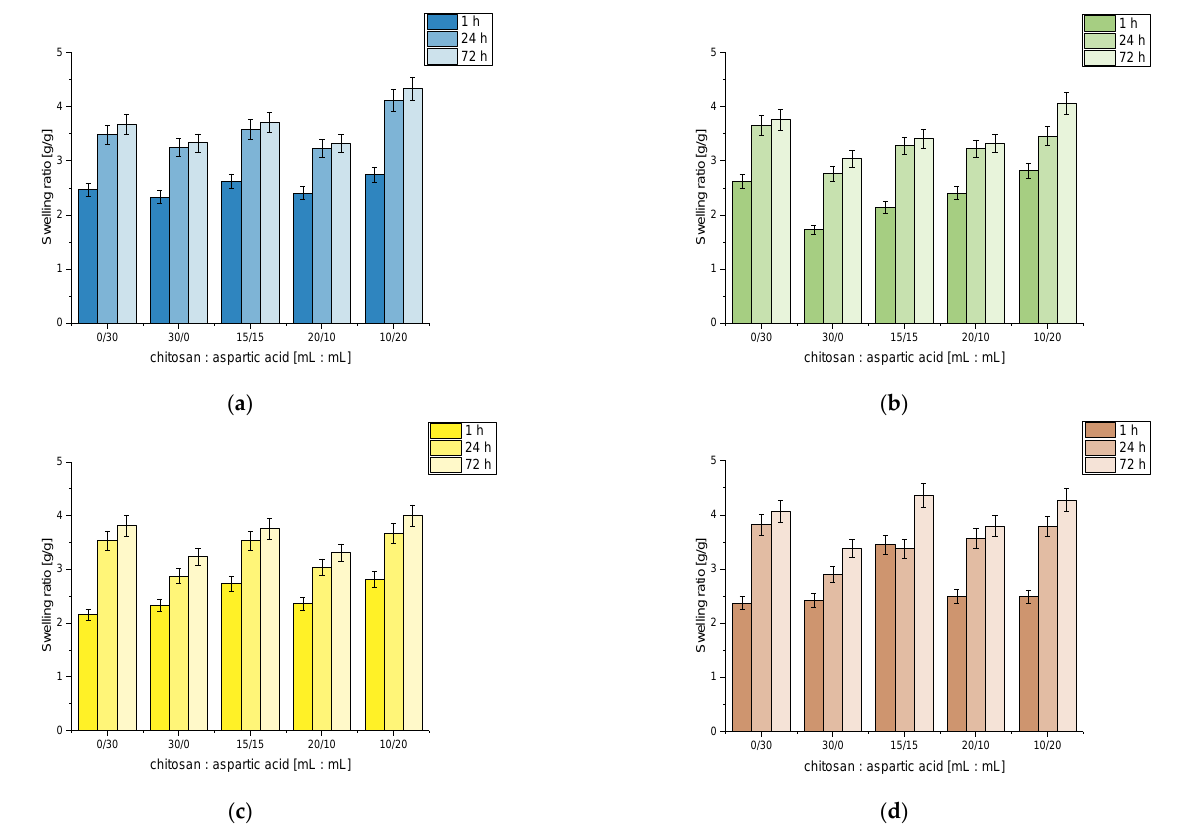
Figure 3. Results of swelling studies of hydrogels in distilled water ( a ), Ringer liquid ( b ), SBF ( c ) and hemoglobin ( d ).